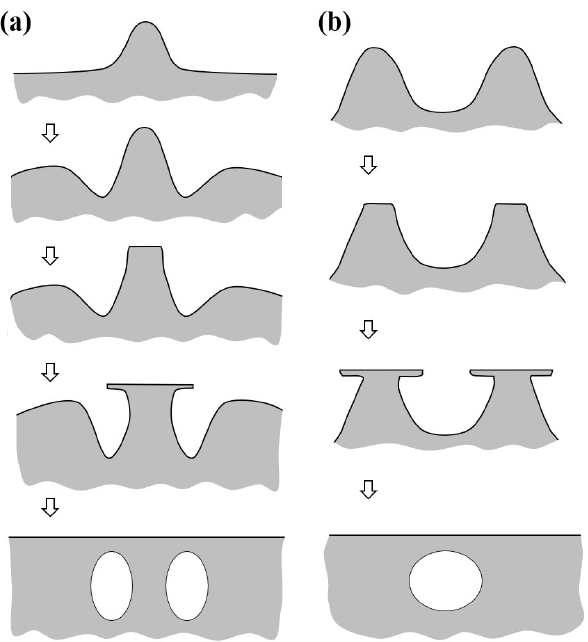
Figure B14. Development of ridge channel pockets. (a) Adjacent to main ridge. (b) Between side ridges. Compare to A and B in Fig. B13b.